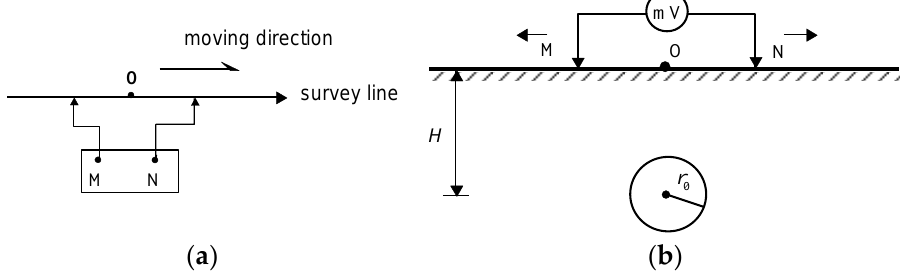
Figure 3. ( a ) A schematic diagram of a profile detection device and ( b ) a sounding device of